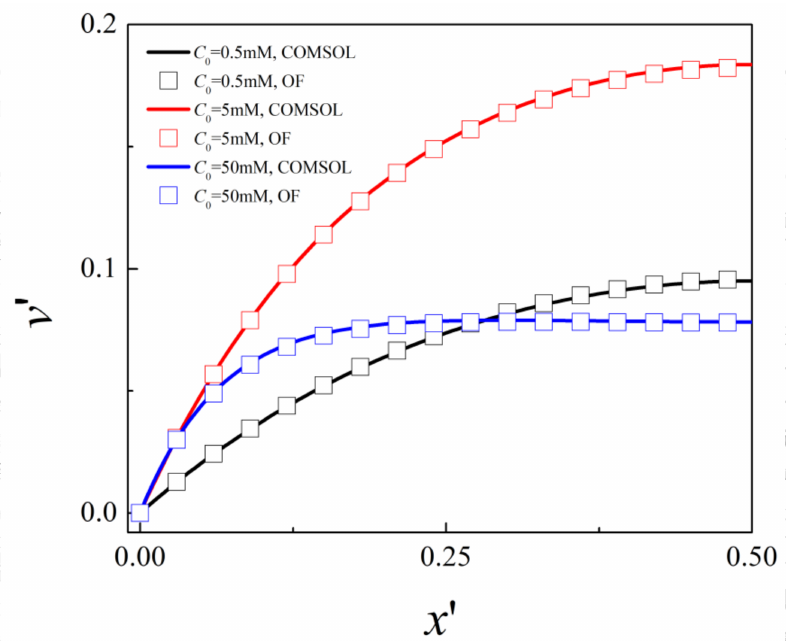
Figure 2. Distribution of the dimensionless axial velocity at the center of the nanochannel for bulk salt concentrations C 0 = 0.5 mM, 5 mM, and 50 mM: symbols (OpenFOAM) and lines